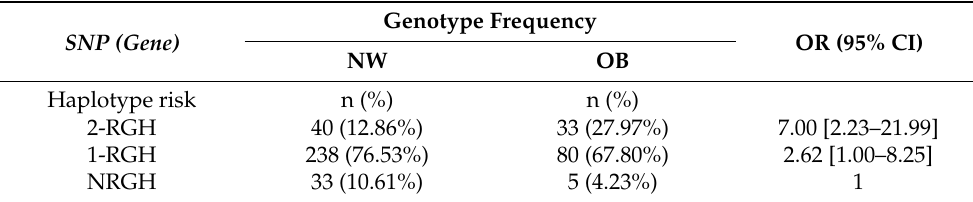
Table 3. Risk-haplotype analysis of rs712221 and rs2016520. SNP